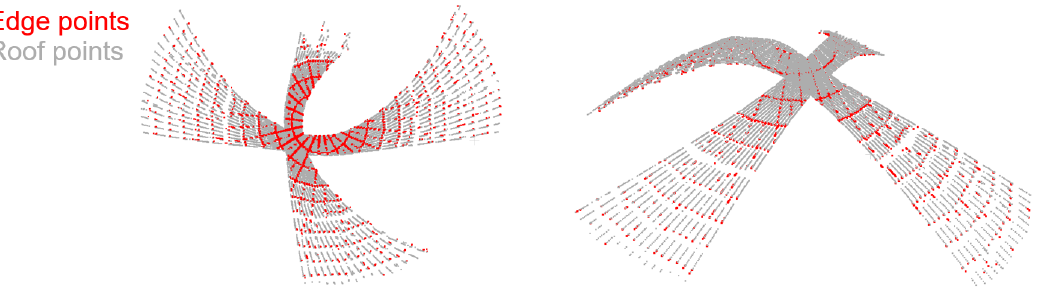
Figure 16. A sample edge point detection result for a roof feature in one scan (left: top view, right: perspective view).